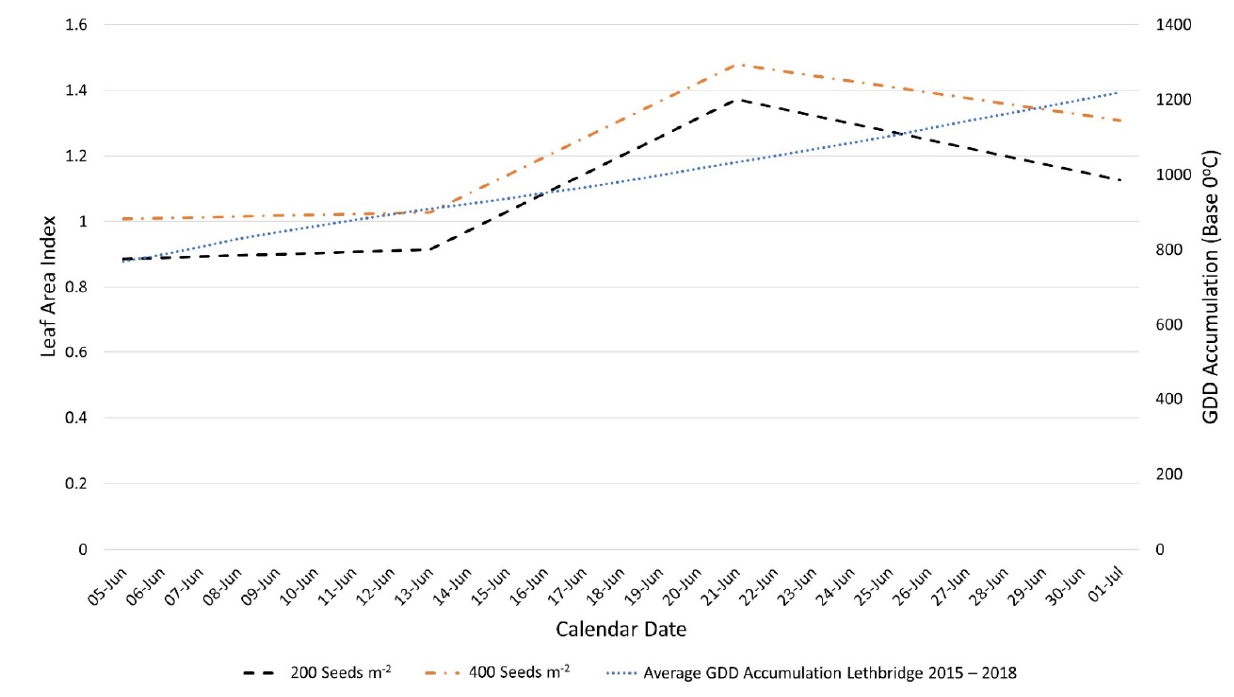
Figure 5. Average leaf area index (LAI) values from 5 June to 1 July at Lethbridge, Alberta sites 2015–2018 for each seeding rate, overlaid with 2015–2018 average GDD B 0 accumulation during the same time period. The optimum seeding rate (400 seeds m − 2 ) had significantly greater LAI than the 200 seeds m − 2 seeding rate on 5 June and 13 June ( p < 0.05). No significant differences in LAI between seeding rates was present 21 June to 1 July.